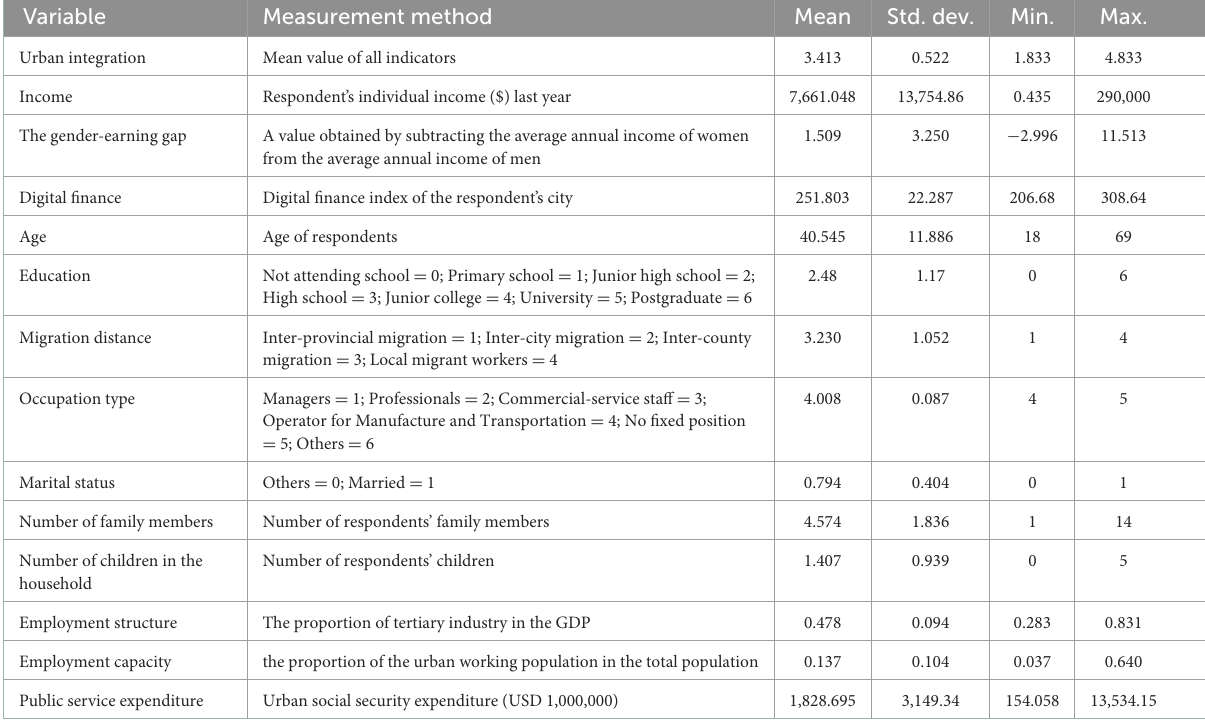
TABLE 2 Variable definitions and descriptive statistics.